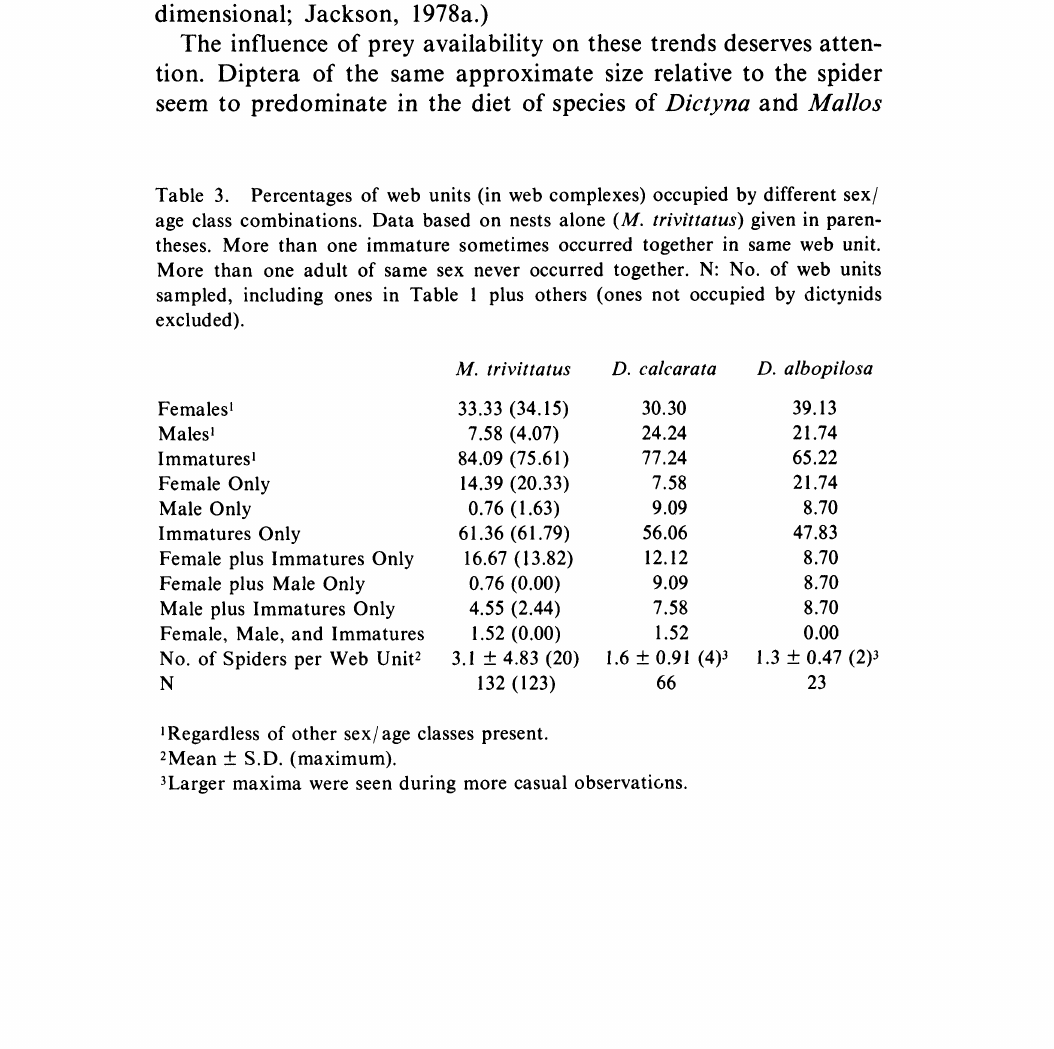
Table 3. Percentages of web units (in web complexes) occupied by different sex/ age class combinations. Data based on nests alone (M. trivittatus) given in paren- theses. More than one immature sometimes occurred together in same web unit. More than one adult of same sex never occurred together. N: No. of web units sampled, including ones in Table plus others (ones not occupied by dictynids